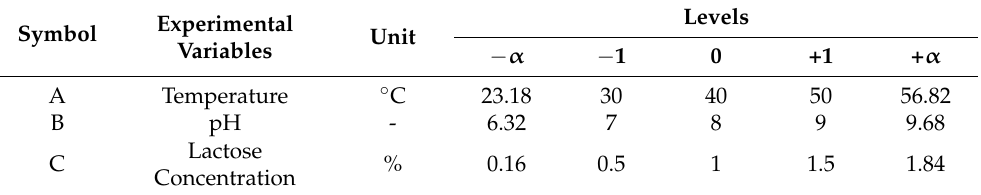
Table 1. Experimental variables and their levels employed in RSM study for optimizing coproduction.